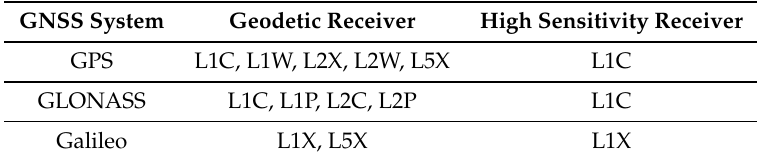
Table 2. Receiver independent exchange format (RINEX) specifiers of recorded phase observations on different frequencies with geodetic and high sensitivity receivers.